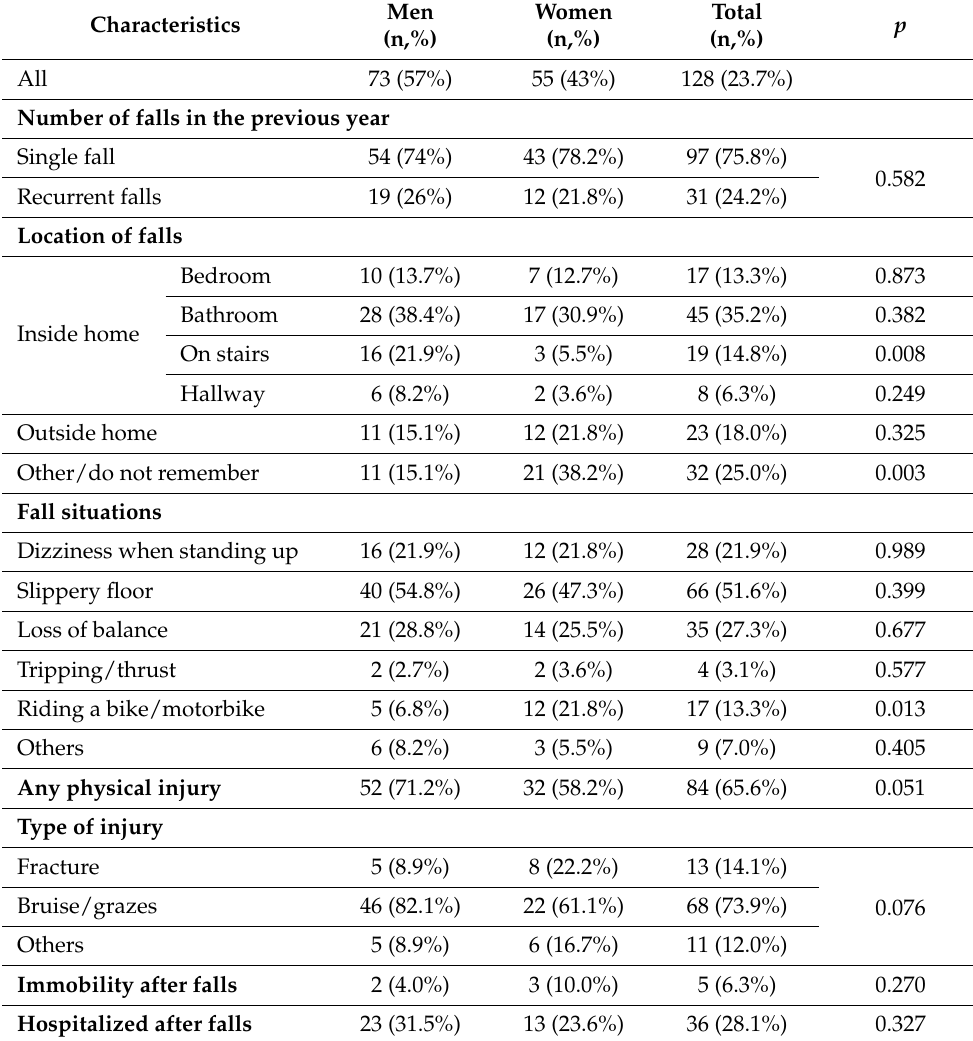
Table 2. Characteristics of falls in older participants (faller group).